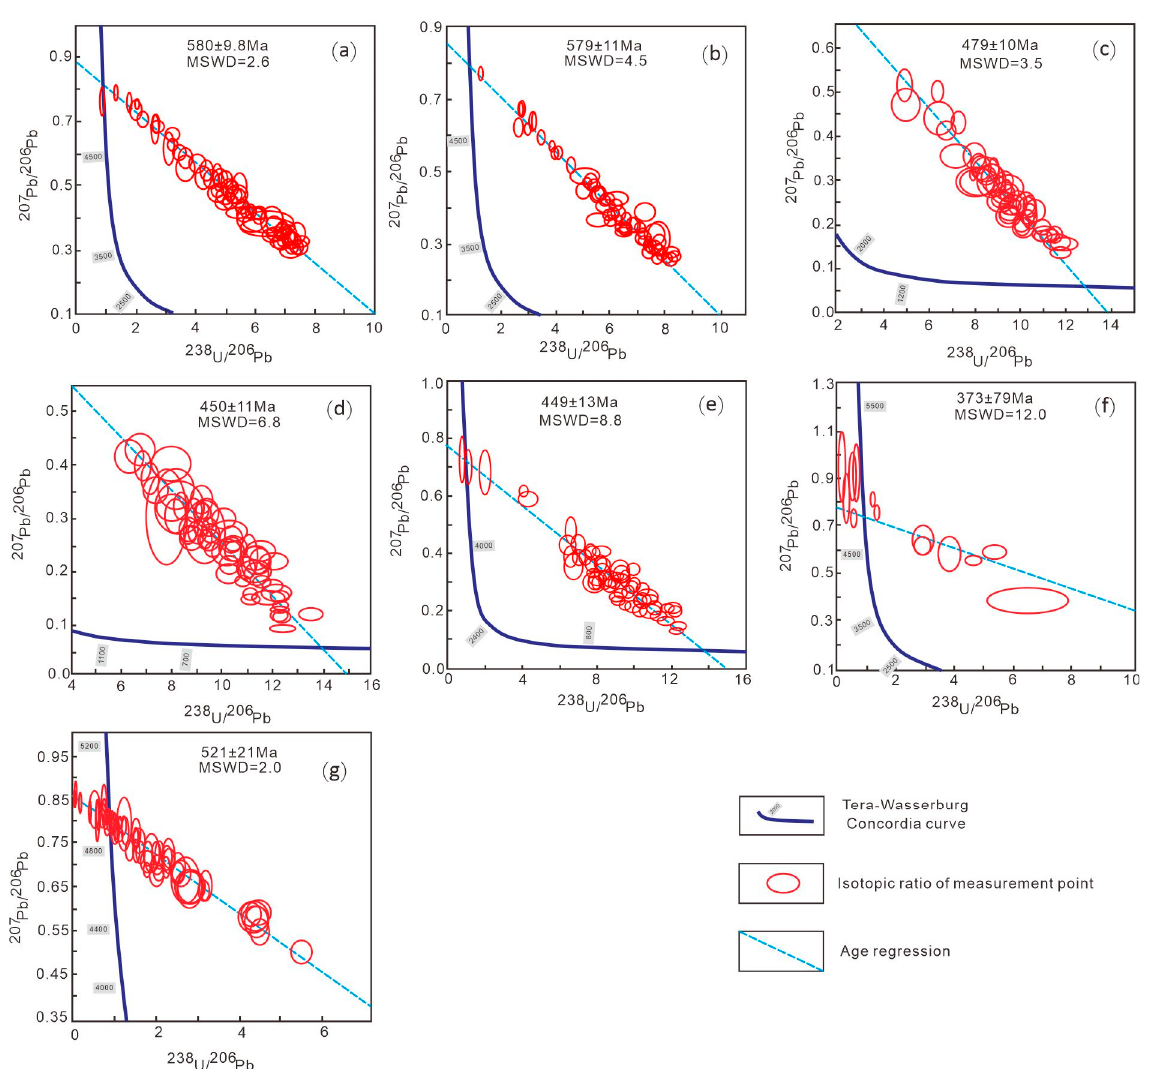
Figure 6. The U-Pb dating results from different fabrics of the microbial dolomite in the Dengying Formation, Eastern Sichuan (the sample ages were regressed on Tera-Wasserburg plots using Isoplot 3.0 [55] after raw data were processed by Iolite 3.6 [56]). ( a ) The host rock of the thrombolite dolostone (MD), formed at 580 ± 9.8 Ma, sample HF-Dn2, the 2th Member of the Dengying Formation in the Hanfengya profile; ( b ) the fibrous dolomite (FD-I), formed at 579 ± 11 Ma, sample HF-Dn2, the 2th Member of the Dengying Formation in the Hanfengya profile; ( c ) the Bladed dolomite (BD-II), formed at 479 ± 10 Ma, sample HF-Dn1, the 2nd Member of the Dengying Formation in the Hanfengya profile; ( d ) the brown-dark dolomite cement (BDD-III), formed at 450 ± 11 Ma, sample HF-Dn1, the 2nd Member of the Dengying Formation in the Hanfengya profile; ( e ) the brown-dark dolomite cement (BDD-III), formed at 449 ± 13 Ma, sample HF-Dn1, the 2nd Member of the Dengying Formation in the Hanfengya profile; ( f ) the medium-coarse crystalline dolomite (MCCD-IV), formed at 373 ± 79 Ma, sample HF-Dn1, the 2nd Member of the Dengying Formation in the Hanfengya profile; ( g ) The fibrous dolomite (FD-I), formed at 521 ± 21 Ma, sample BJ-Dn4, the 4th Member of the Dengying Formation in the Bajiaoxi profile.